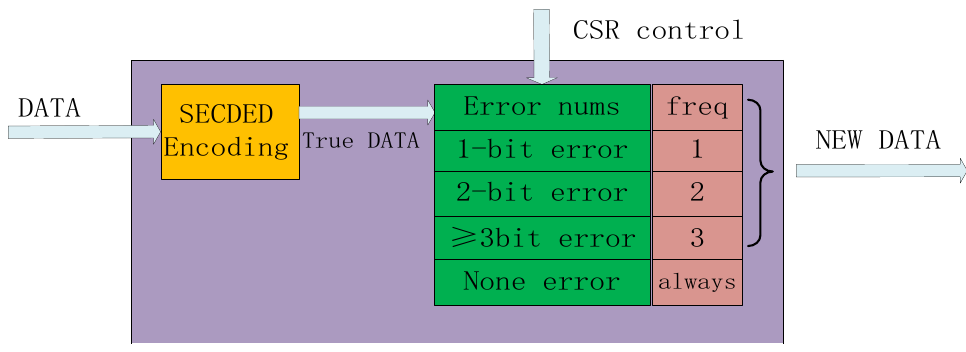
Figure 23. Encoding embedded in the CSR control module.